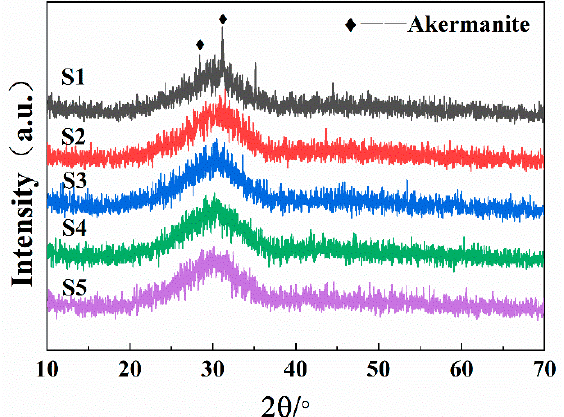
Figure 1. XRD patterns of quenched samples with different SiO 2 /CaO ratios.